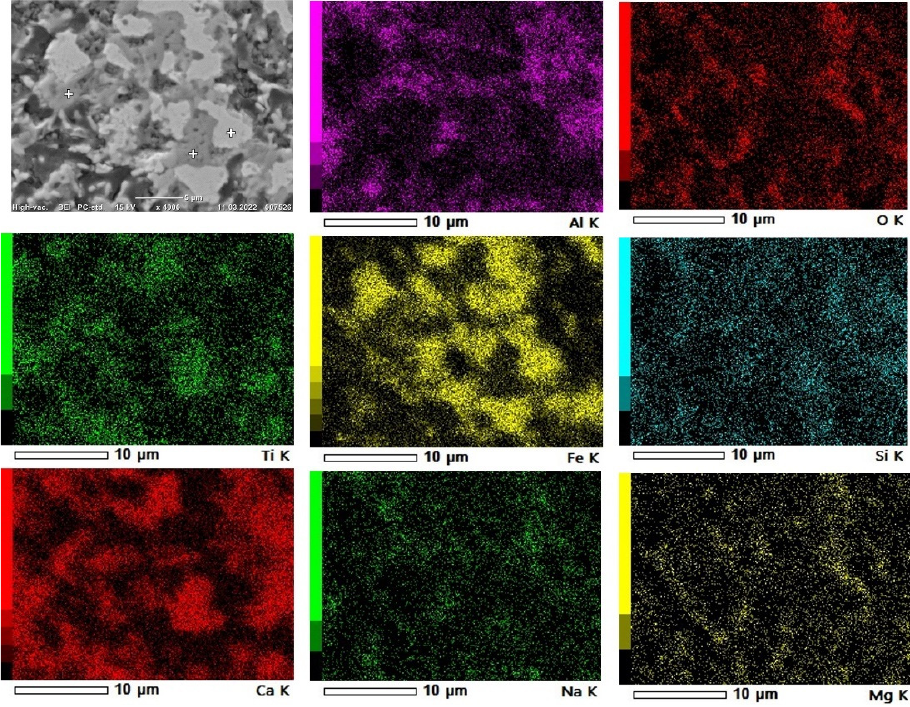
Figure 11. X-ray mapping of elements and BEI of reduced sample 1.